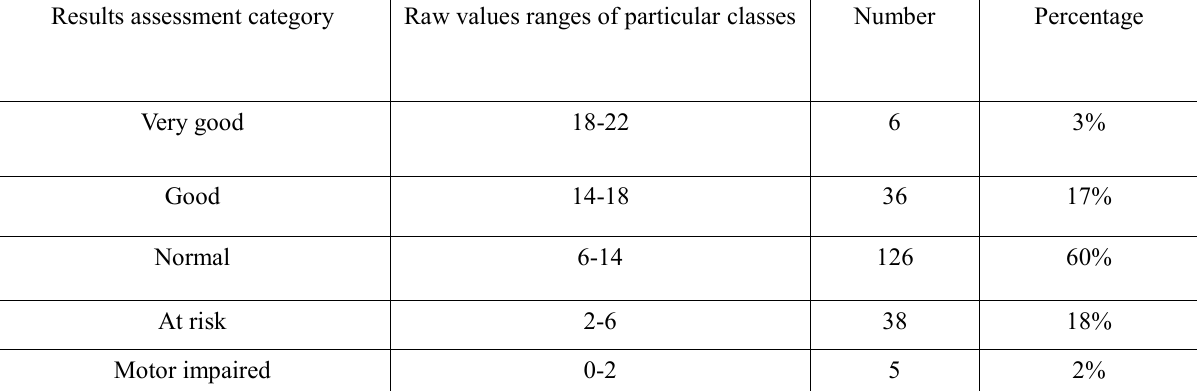
Category structure of results assessment in the modified MOT 4-6 examination – the younger group. Set of figures.